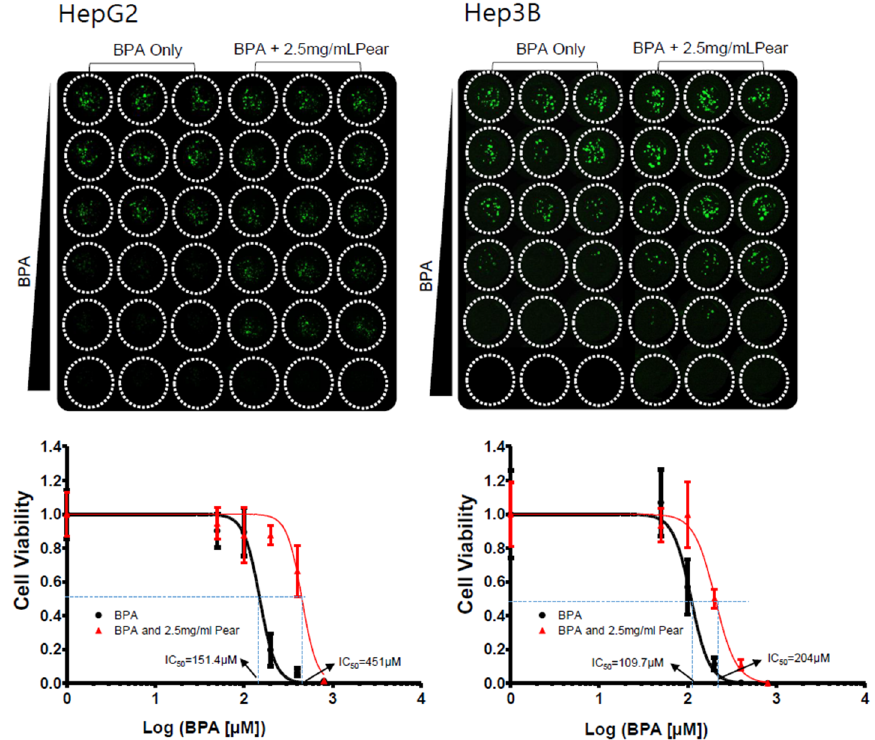
Figure 4. Korean pears reduced BPA cytotoxicity in both Hep3B cells and HepG2 cells under the micropillar/microwell platform.